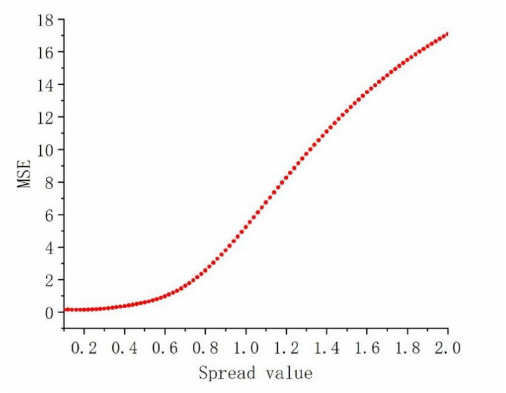
Figure 5. The mean-square-error (MSE) at di ff erent spread values.